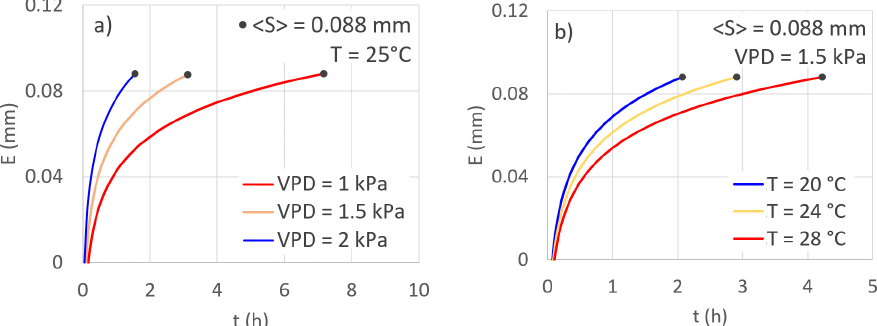
Figure 6. Performance of the simplified evaporation model ( a ) for fixed temperature T, by varying the vapour pressure deficit, VPD, and ( b ), for fixed VPD, by varying the temperature, T. From a practical point of view, the usefulness of such calibrated relationships lays in their ability to estimate the evaporation losses, starting with any initial conditions, t 0 , when applied in combination with an interception model, such as that suggested by Baiamonte [23]. A more extended validation of such a procedure was performed by considering that the evaporation losses are only described by the shape parameter, n , of the semi-log rela- tionship, as observed in the previous section: Δ𝐸 = (cid:4666)a + a (cid:2869) 𝑆 + a (cid:2870) VPD + a (cid:2871) T(cid:4667) 𝑙𝑜𝑔 (cid:3436)𝐷𝑆 + 𝑡 (cid:2868) 𝑡 (cid:2868)